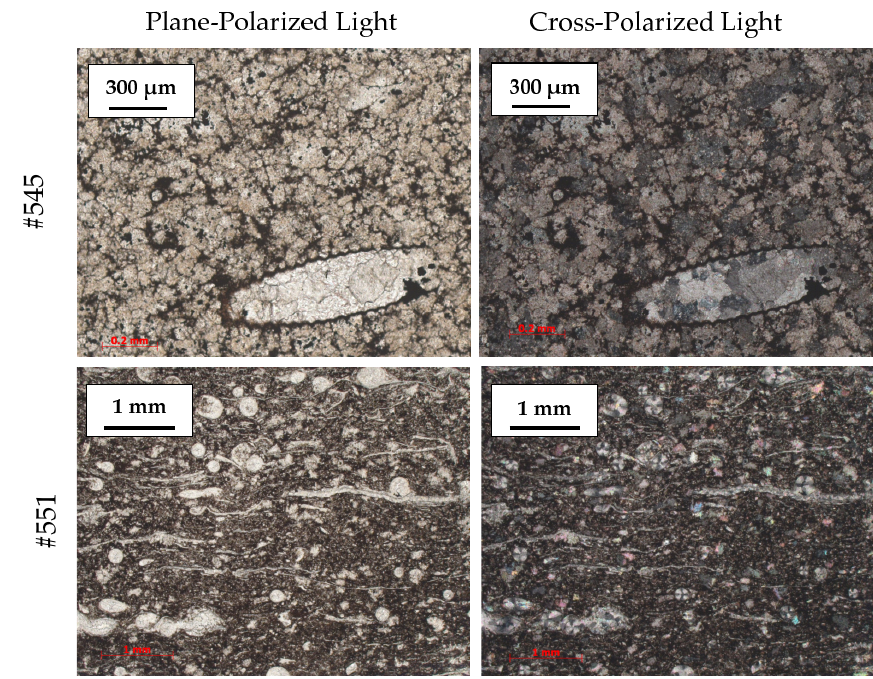
Figure 7. Petrographical analysis of thin-sections located at the closest depth to samples #545 and